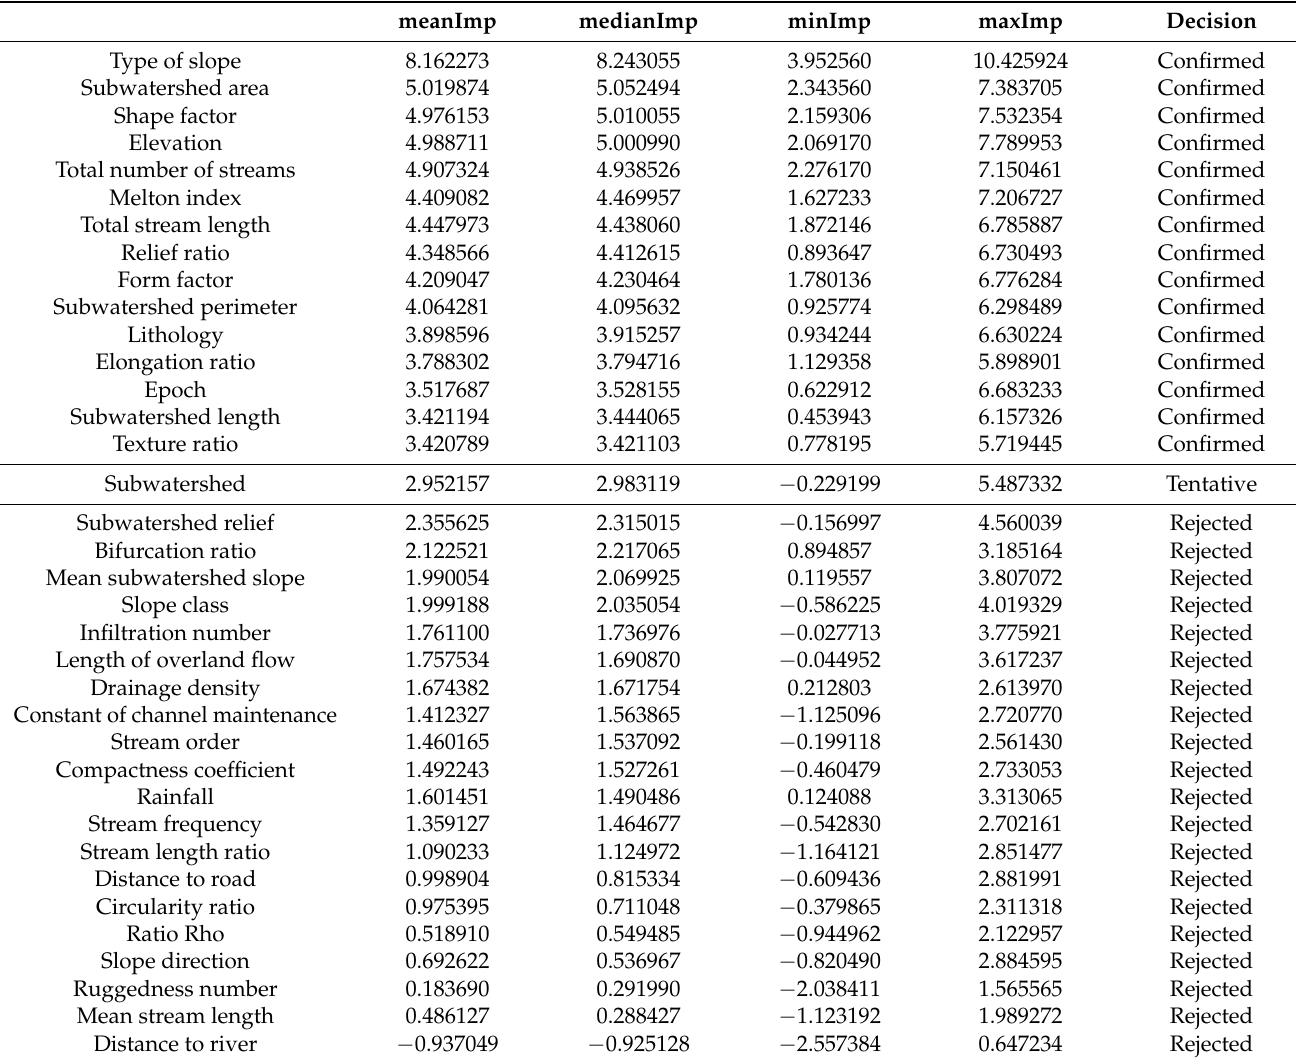
Table 2. Variable importance using Boruta feature